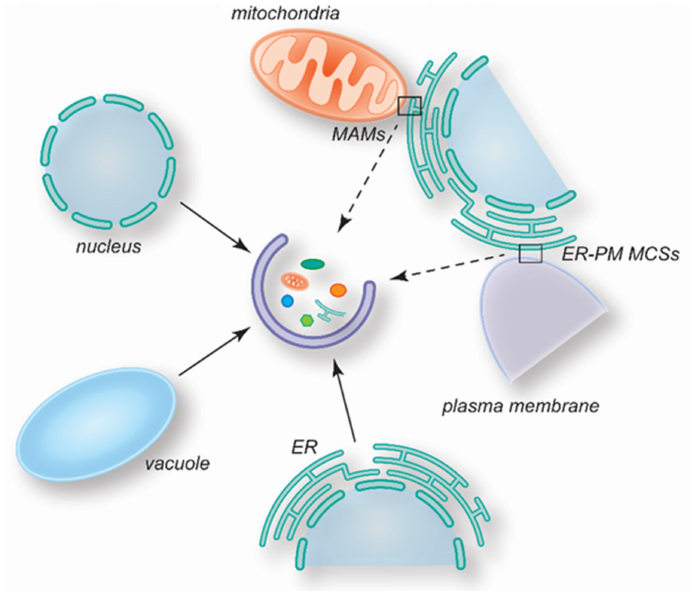
Figure 4. Overview of the MCSs involved in autophagosome biogenesis. Several MCSs play a role in the regulation of autophagy, contributing in different ways. Continuous arrows highlight MCSs between organelles and the phagophore. Dashed arrows indicate MCSs between organelles that participate in the formation of